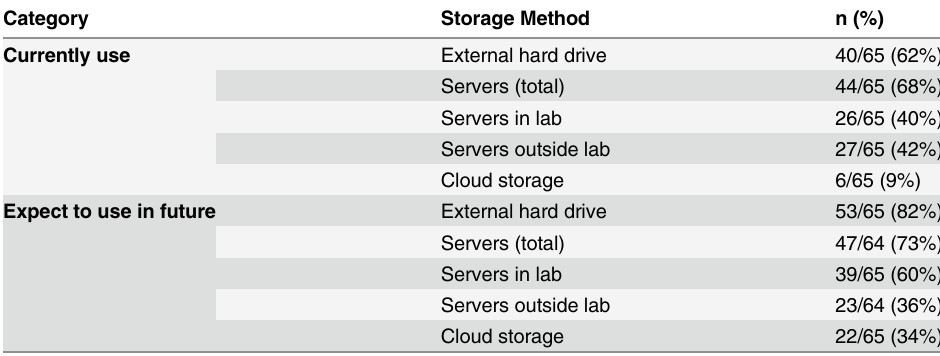
Table 7. Current and future storage methods for NGS data ( Current Users